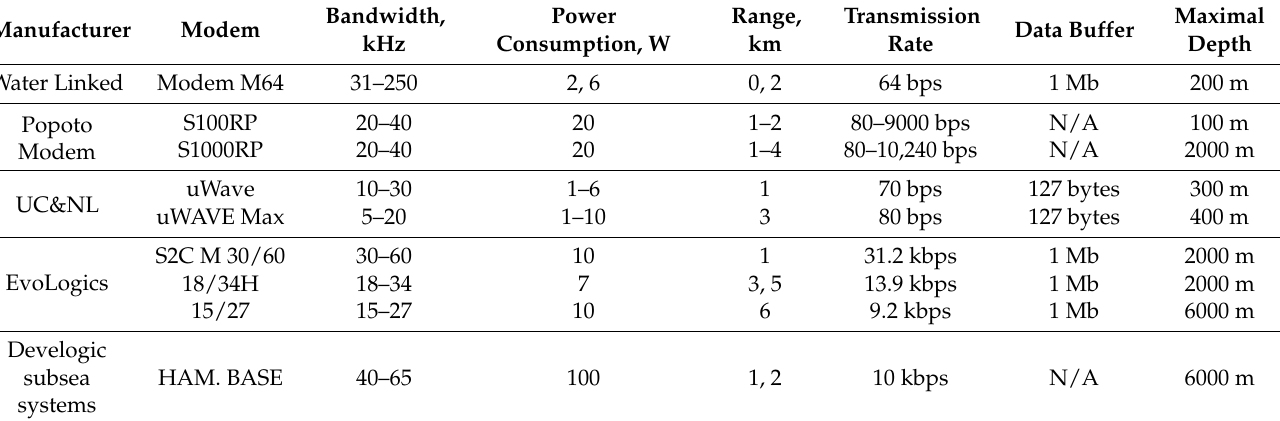
Table 3. Hydroacoustic modems’ technical characteristics